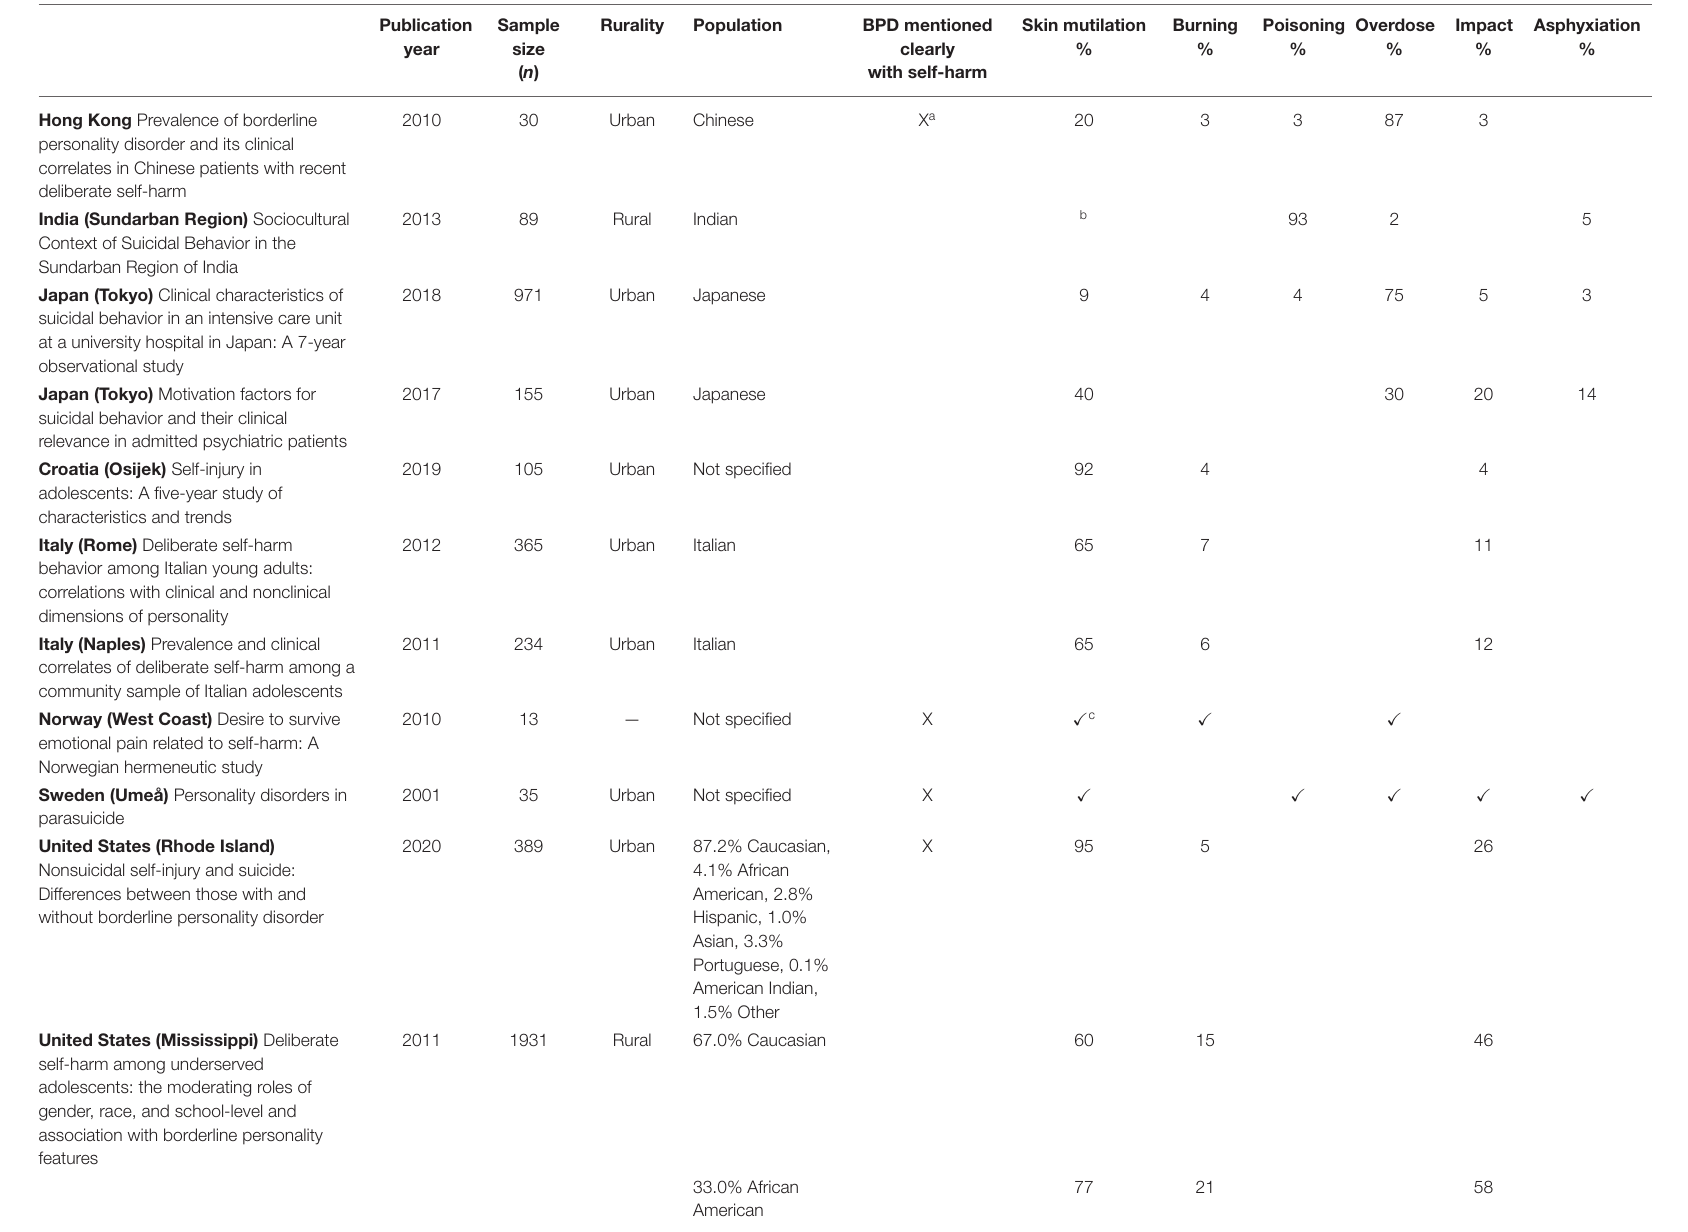
TABLE 3 | Methods of self-harm by study based on 13 BPD